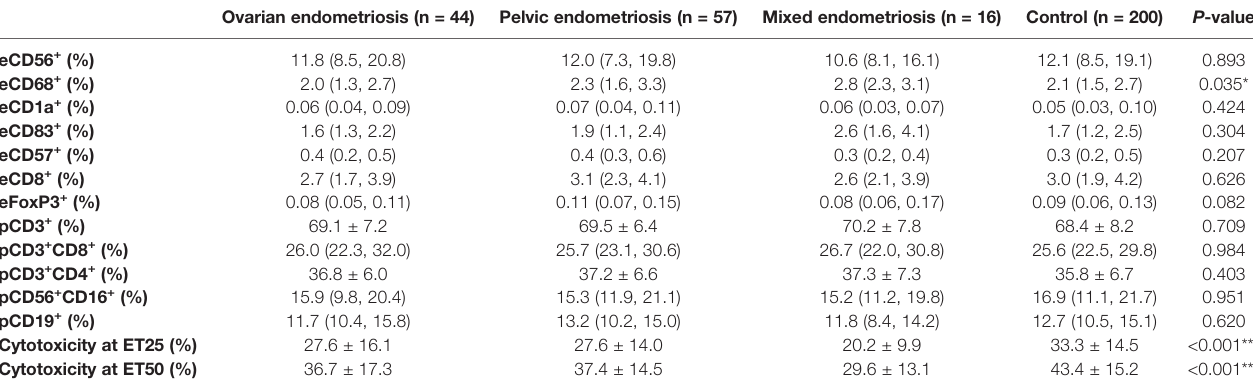
TABLE 3 | Comparison of lymphocyte subsets from endometrium or peripheral blood and cytotoxicity of peripheral NK cells among females in different endometriosis subgroups and the control group. Ovarian endometriosis (n = 44) Pelvic endometriosis (n = 57) Mixed endometriosis (n = 16) Control (n = 200) P -value